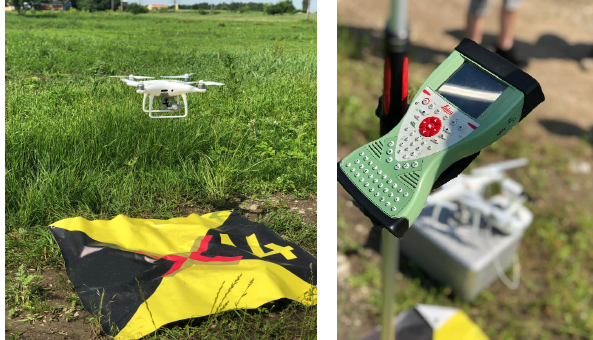
Figure 1. Presentation of UAV Phantom 4 Pro equipment, used ground control points (GCPs), of GNSS Leica GS08 equipment and the resulted orthophoto